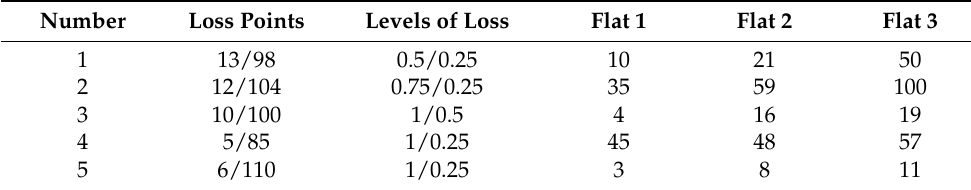
Table 1. High risk and low risk loss points and